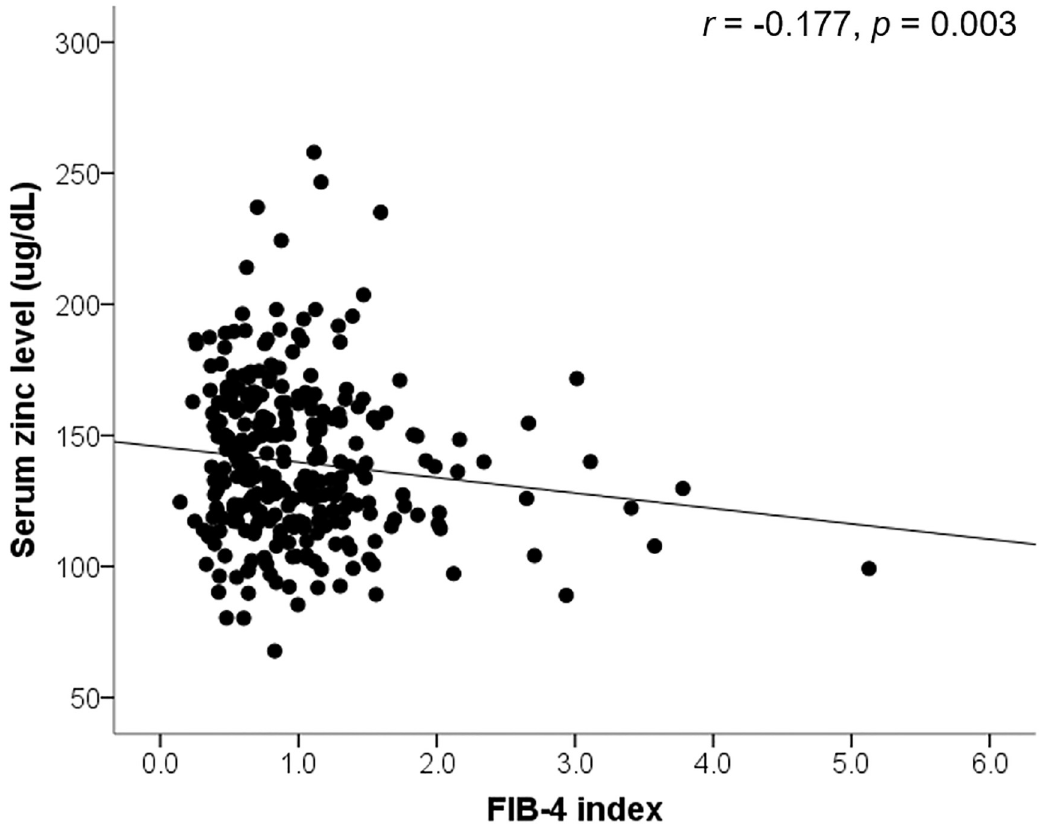
Fig 2. The relationship between serum zinc level and hepatic fibrosis (FIB-4 index) in subjects with NAFLD. “ r ” is Partial correlation coefficient adjusting gender, body mass index, gamma glutamyl transferase, fasting glucose level, triglyceride, low density lipoprotein cholesterol, high density lipoprotein cholesterol, diabetes mellitus, and vitamin D level. Abbreviations: NAFLD, nonalcoholic fatty liver disease; FIB-4, fibrosis-4. cholesterol, HDL cholesterol, diabetes mellitus, and vitamin D level between serum zinc level and FIB-4 index is r = -0.177 with p = 0.003. We investigated the difference in FIB-4 index according to serum Zn level ( < 120, 120–140, 140–160, and � 160 μ g/dL) (Fig 3). The mean FIB-4 index in serum Zn level < 120, 120–140, 140–160, and � 160 μ g/dL were 1.06 ± 0.74, 1.08 ± 0.66, 0.96 ± 0.47, and 0.83 ± 0.43, respectively. The FIB-4 index significantly increased as serum Zn level decreased ( p = 0.01). There is an inverse relationship between serum Zn level and hepatic fibrosis in NAFLD.